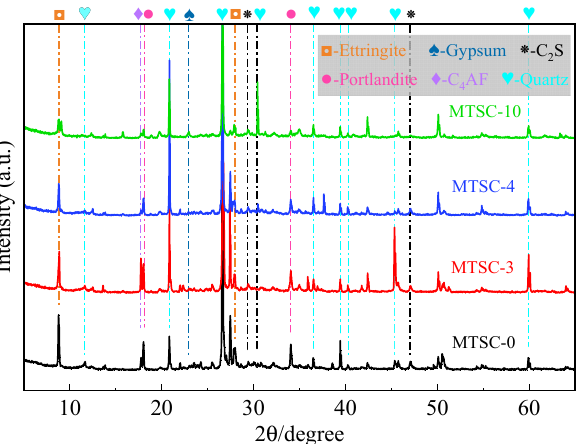
Figure 10. The XRD patterns of MTSC-0, MTSC-3, MTSC-4 and MTSC-10.